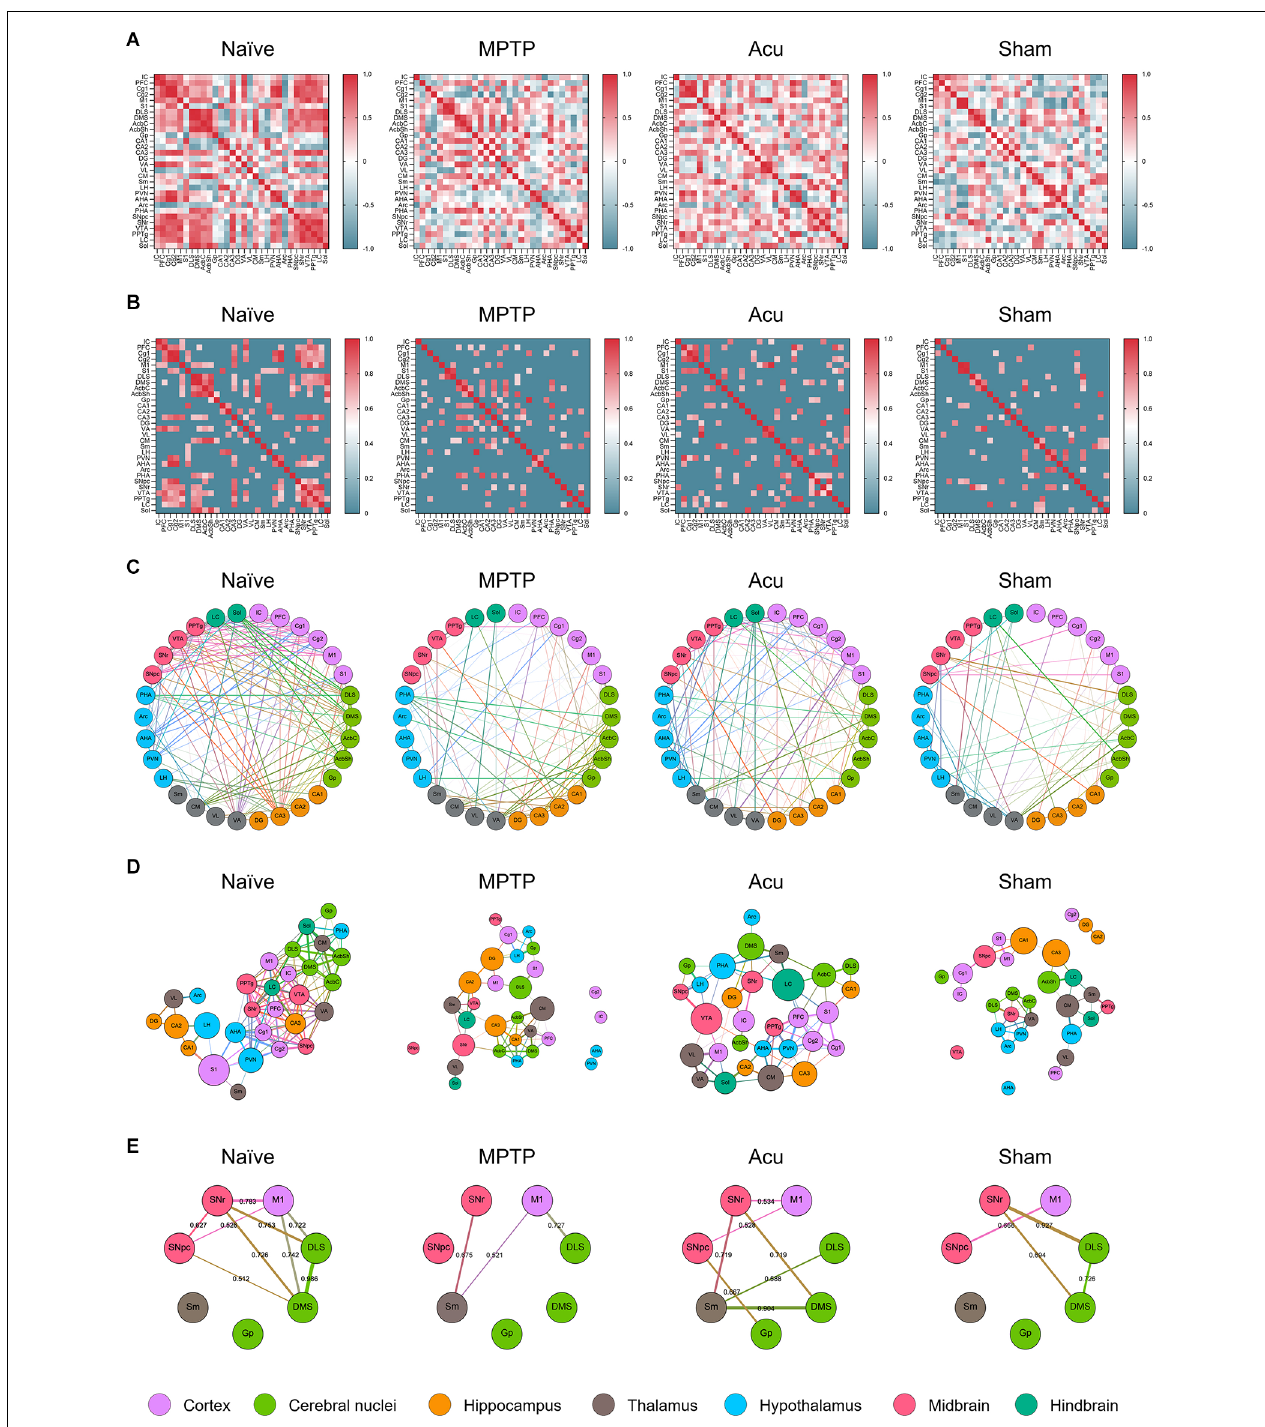
FIGURE 2 | Correlation matrix between regions and clustering of network configurations via brain c-Fos expression within each group. (A) Color-coded matrices showing inter-regional correlations for c-Fos activation between the 30 brain regions. (B) The threshold square of inter-regional correlations for c-Fos activation. MPTP produces a low correlation between the brain regions, and these correlations were altered by acupuncture treatment. The red color indicates high correlation and blue indicates low correlation. (C) A circular layout grouped by major brain subdivision to show the connectivity between the brain regions. Nodes are connected by the edges of super-threshold inter-regional correlations. (D) A force atlas format to show the degree and betweenness centrality. The number of edges was represented as degree, and the number of shortest paths of all possible pairs of nodes represented betweenness centrality. (E) A circular layout grouped by motor-related brain